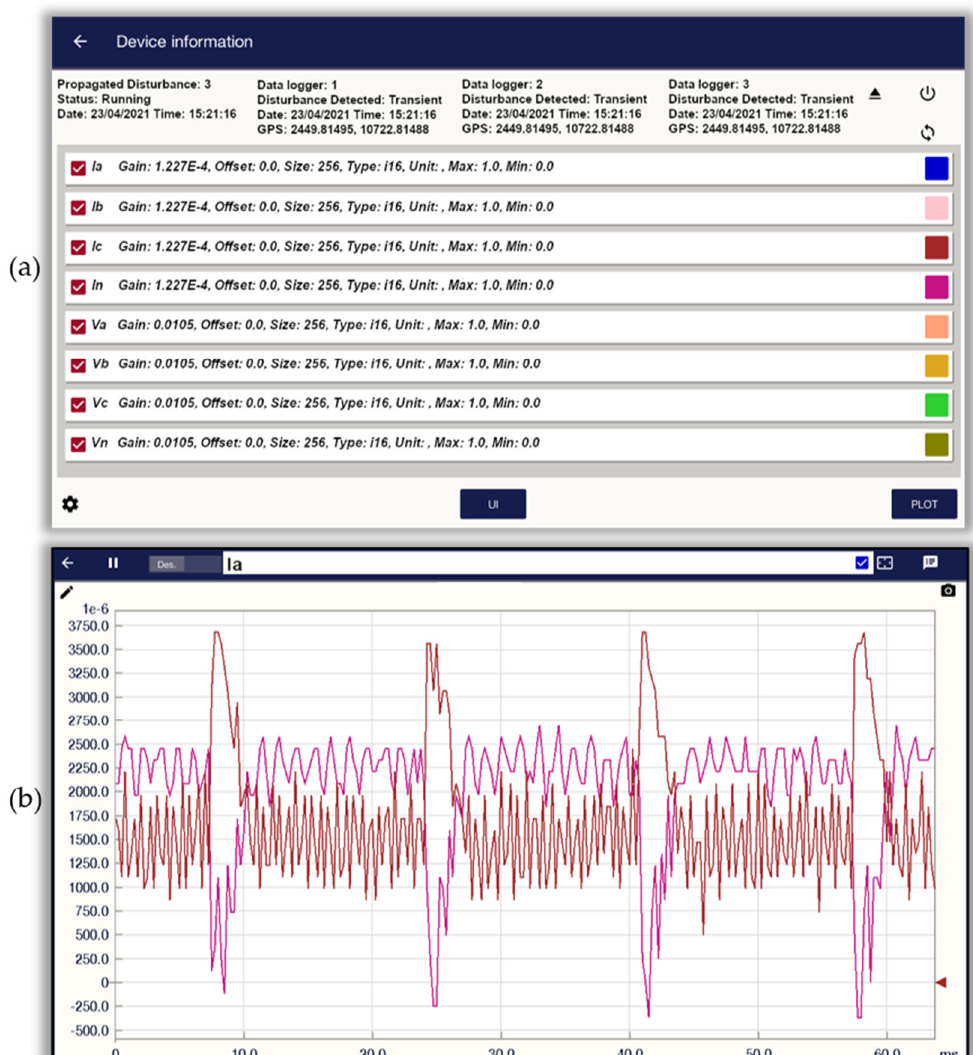
Figure 6. Image interface of the application developed for mobiles to control the proprietary data logger. ( a ) Measurement control screen and configuration of measurement channels: Ia, Ib, Ic, In, Va, Vb, Vc, Vn. ( b ) Real-time signal display screen.